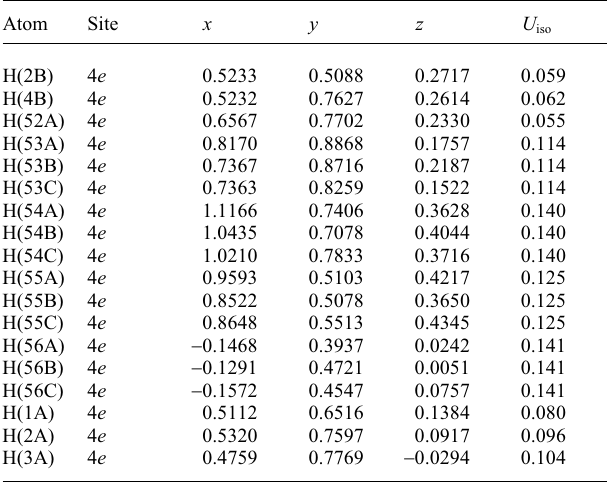
Table 2. Atomic coordinates and displacement parameters (in Å 2 )